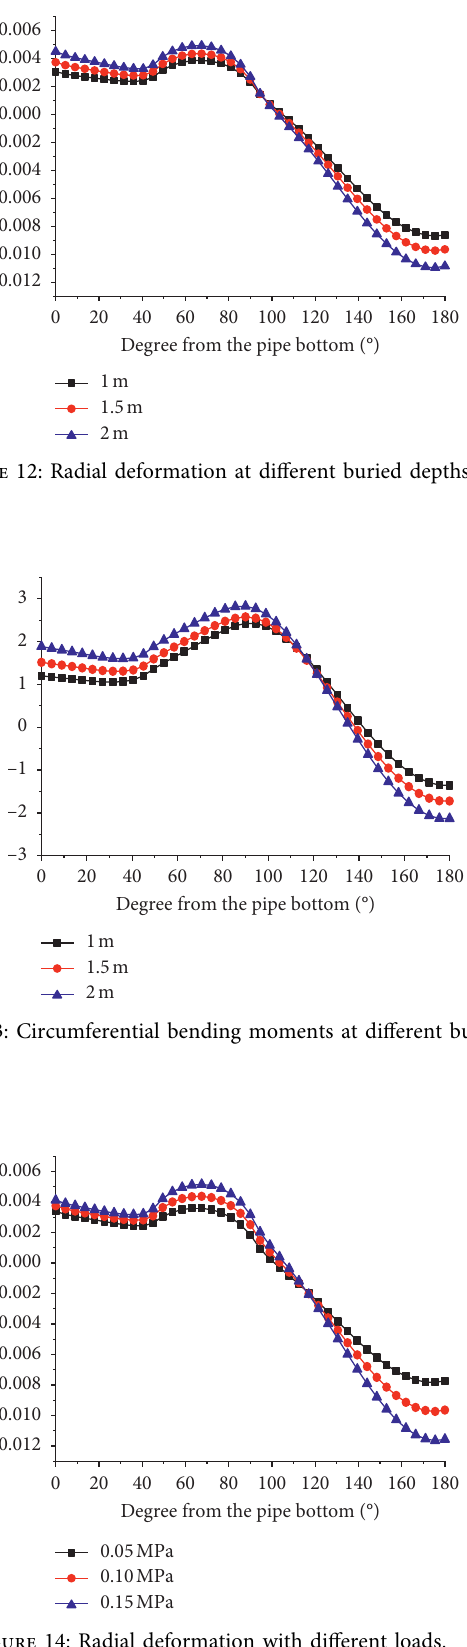
Figure 17: Circumferential bending moments at different soil elastic